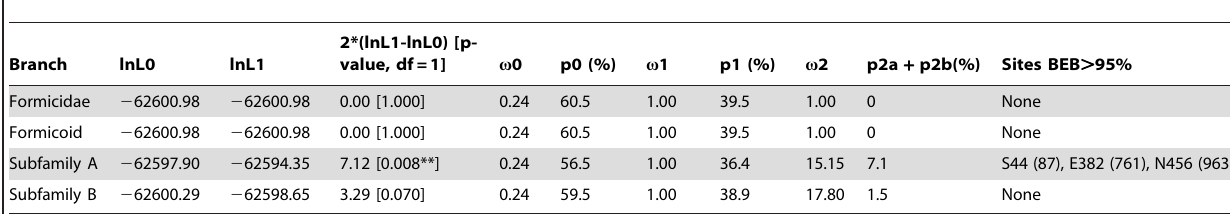
Table 2. Results of test of positive